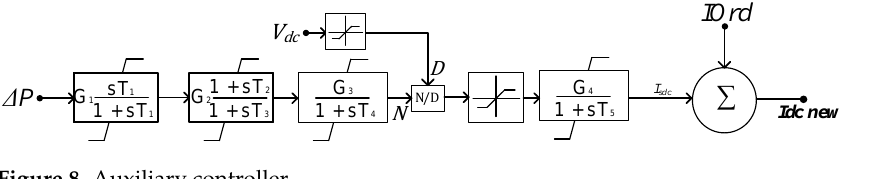
Figure 8. Auxiliary controller.